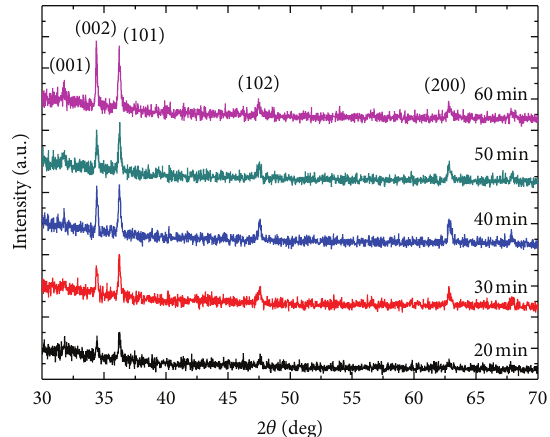
Figure 2: X-ray diffraction patterns of the ZnO:YAG films with various deposition